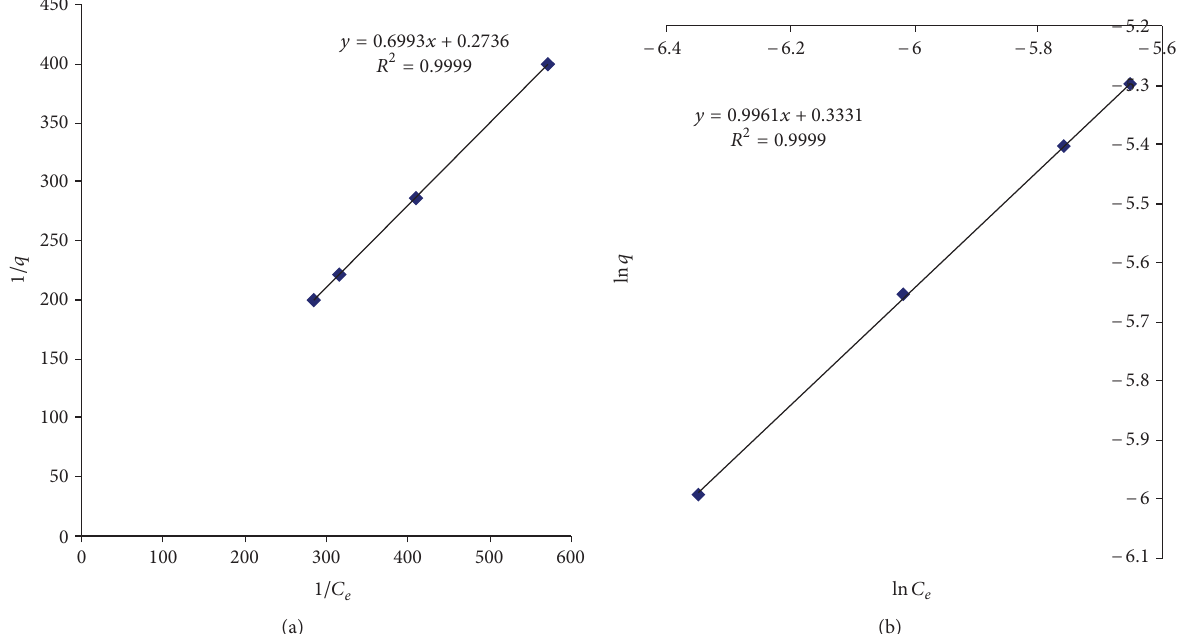
F 4: (a) Langmuir isotherm for copper adsorption using henna leaves. (b) Freundlich isotherm for copper adsorption using Henna